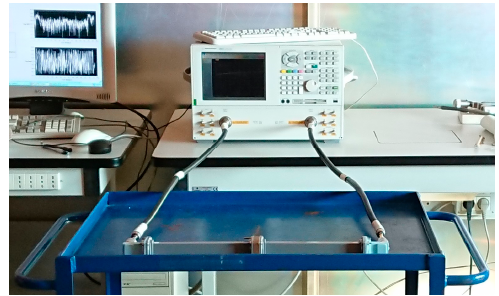
Figure 3. Rectangular waveguide connected to a Vector Network Analyzer (VNA).